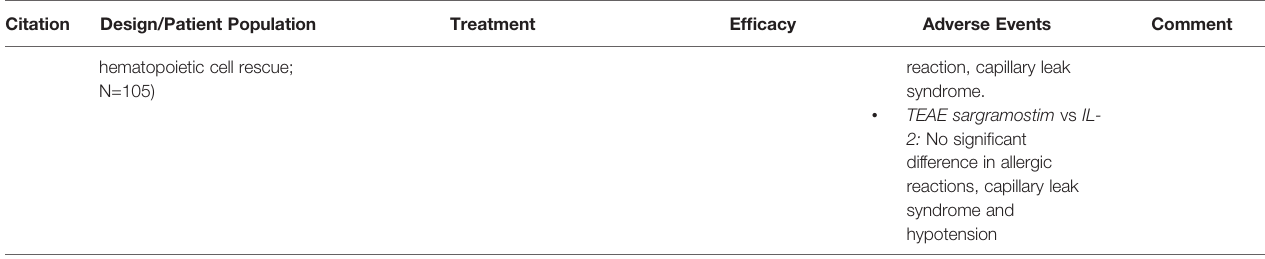
TABLE 4 | Clinical studies evaluating immune-enhancing effects of sargramostim in prostate, colorectal and ovarian cancers.